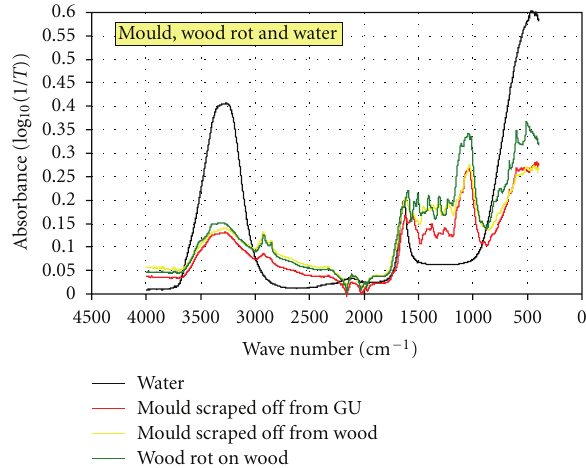
Figure 5: Absorbance (logarithmic) versus wave number between 4000–400 cm − 1 for mould fungi on GU plaster board, mould fungi on a wood sample and wood rot at selected exposure levels. In addition, the water spectrum is also plotted as a comparison. From Figures 2–4 (except water